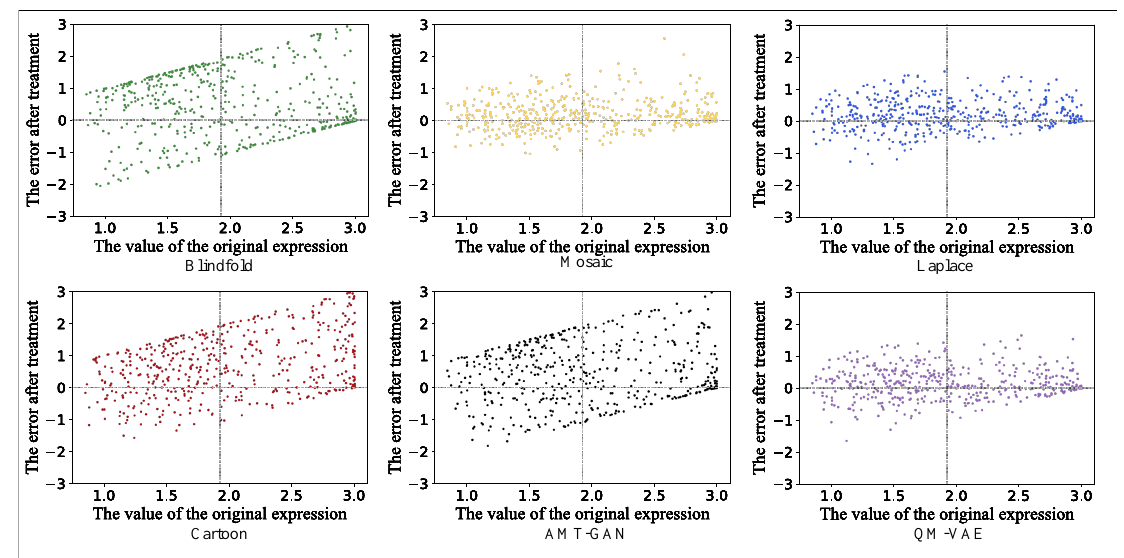
Figure 9. The scatter distribution diagram of the difference between the result values of facial expression recognition before and after processing by different methods.